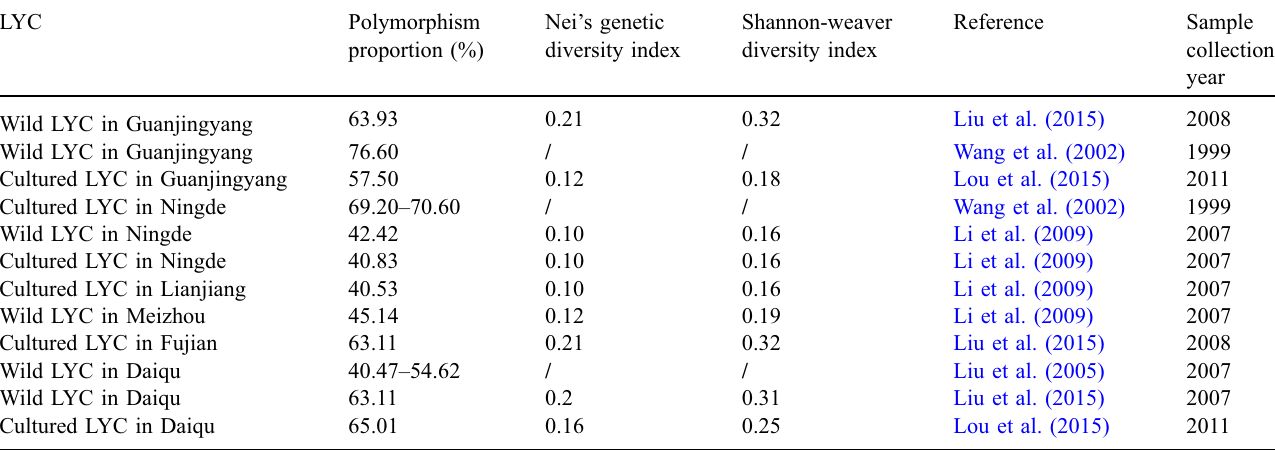
Table 2. Genetic diversity evaluation results of Large Yellow Croaker (LYC) in different geographical groups by using AFLP. LYC